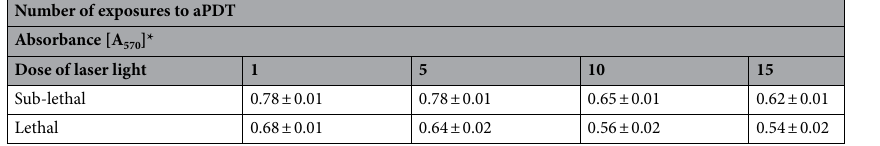
Number of exposures to